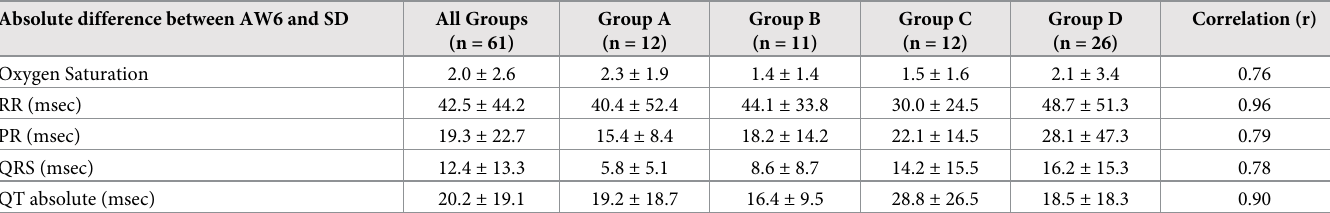
Table 2. Difference between AW6 oxygen saturation and ECG intervals compared to hospital pulse oximeter and 12-lead ECG. SD = standard. Absolute difference between AW6 and SD